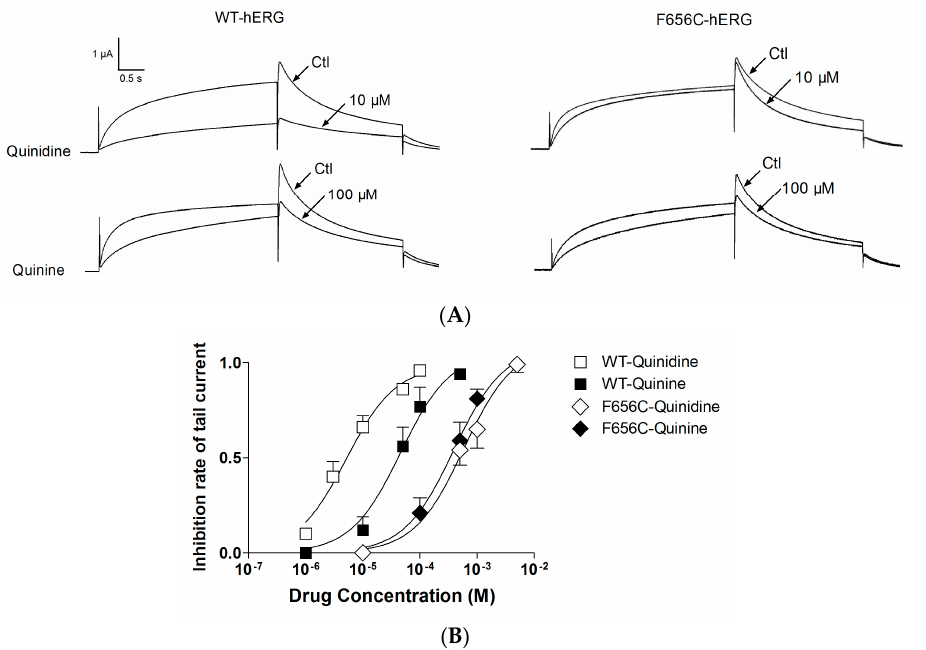
Figure 4. F656C-hERG abrogates the stereospecific differences between quinidine and quinine. ( A ) Representative currents of WT-hERG and F656C-hERG after quinidine or quinine treatment. The protocol is illustrated in Figure 2A. Quinidine 10 μ M exhibited no significant blockage and quinine 100 μ M exhibited slight blockage of F656C-hERG; ( B ) The extent of blockage of WT-hERG or F656C-hERG by quinidine and quinine. IC 50 of quinidine and quinine for F656C-hERG was 771 ± 81 μ M and 391 ± 40 μ M, respectively. Quinine is more potent than quinidine in blocking F656C-hERG in comparison to blocking WT-hERG. Abbreviations: ctl, control; WT-hERG, wild type hERG; F656C-hERG, phenylalanine in 656 mutanted to cysteine.